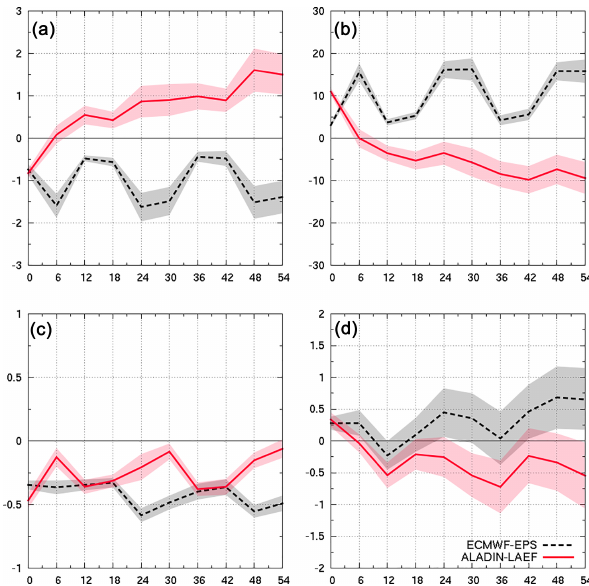
Figure 9. Bias of 2m temperature (a) , relative humidity (b) , 10m wind (c) and mean sea level pressure (d) versus forecast lead time, calculated against SYNOP observations for ECMWF ENS down- scaling (black) and new ALADIN-LAEF Phase I (red). Shading de- notes 10% and 90% confidence